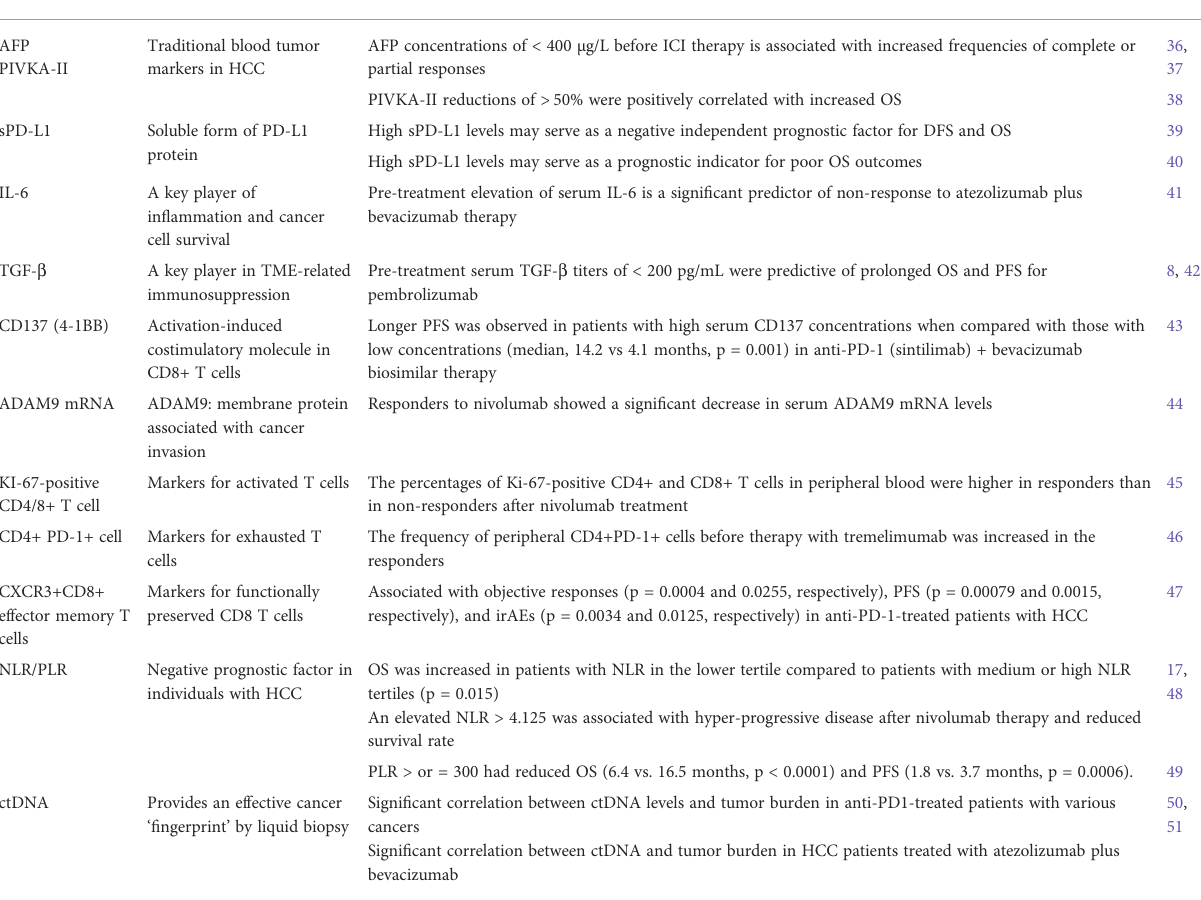
TABLE 1 Blood-based biomarkers for immune-based treatment in advanced HCC. Marker